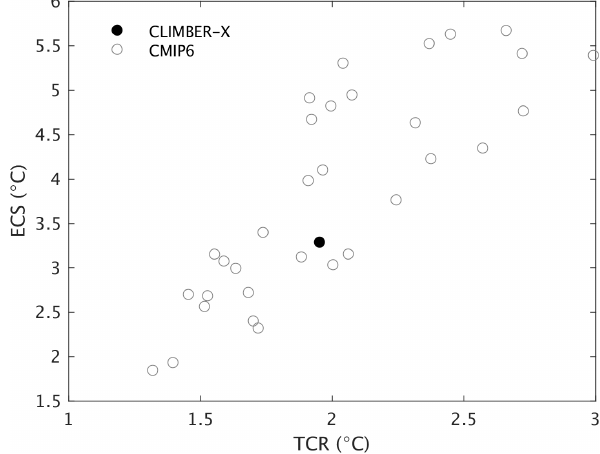
Figure 21. Equilibrium climate sensitivity versus transient climate response for the CLIMBER-X and CMIP6 models. CMIP6 model data are from Nijsse et al.